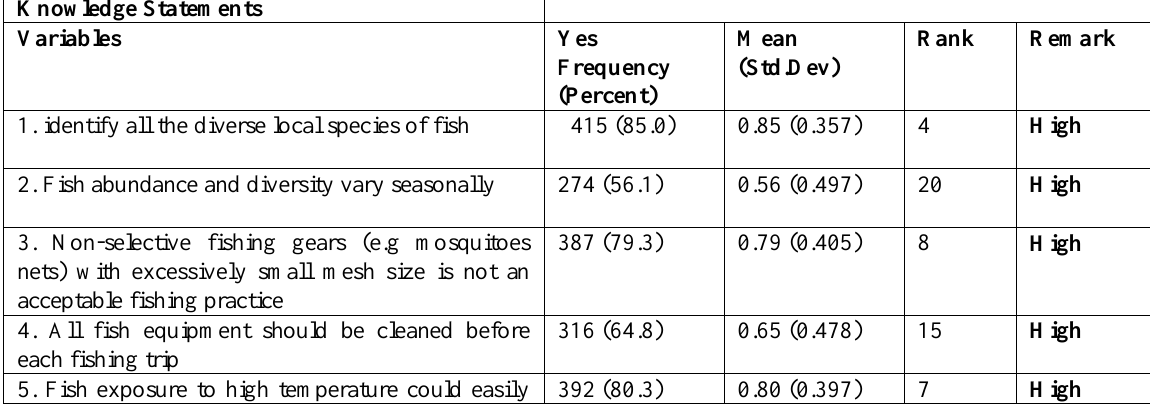
Table 2. Knowledge of sustainable artisanal fishery